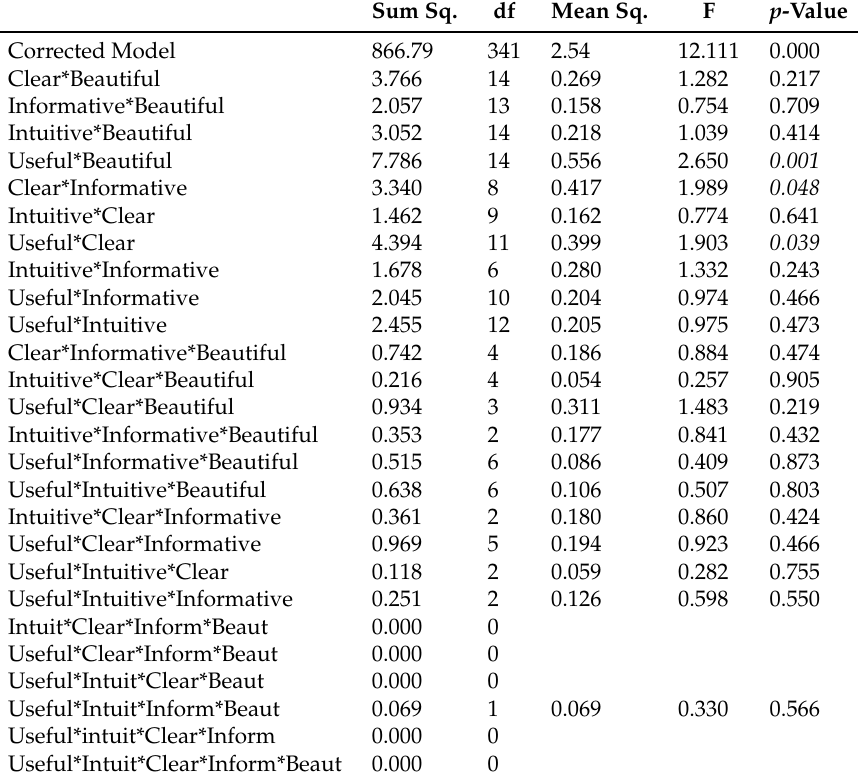
Table 2. Tests of between-subject effects. Dimension names abbreviated by using corresponding adjectives.